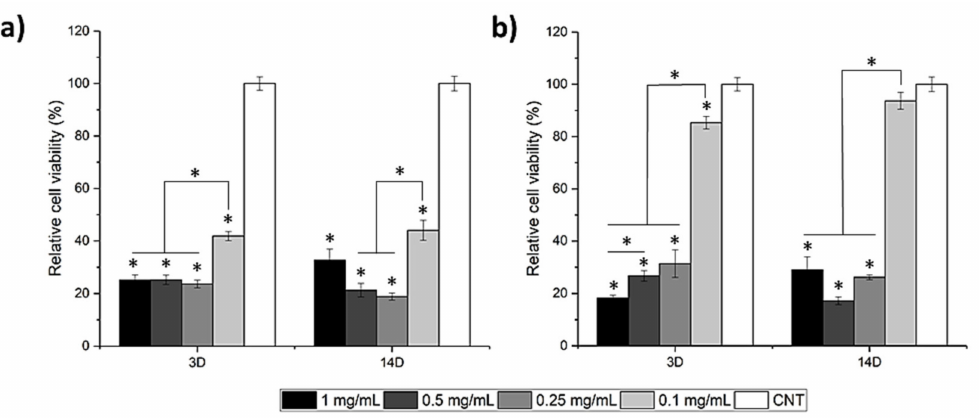
Figure 8. Relative cell viability of ( a ) 1CaHMBGNPs and ( b ) 2CaHMBGNPs at 1, 0.5, 0.25, and 0.1 mg/mL concentration after culture for three (3D) and 14 days (14D). Data are presented as mean ± SD and * indicates p <